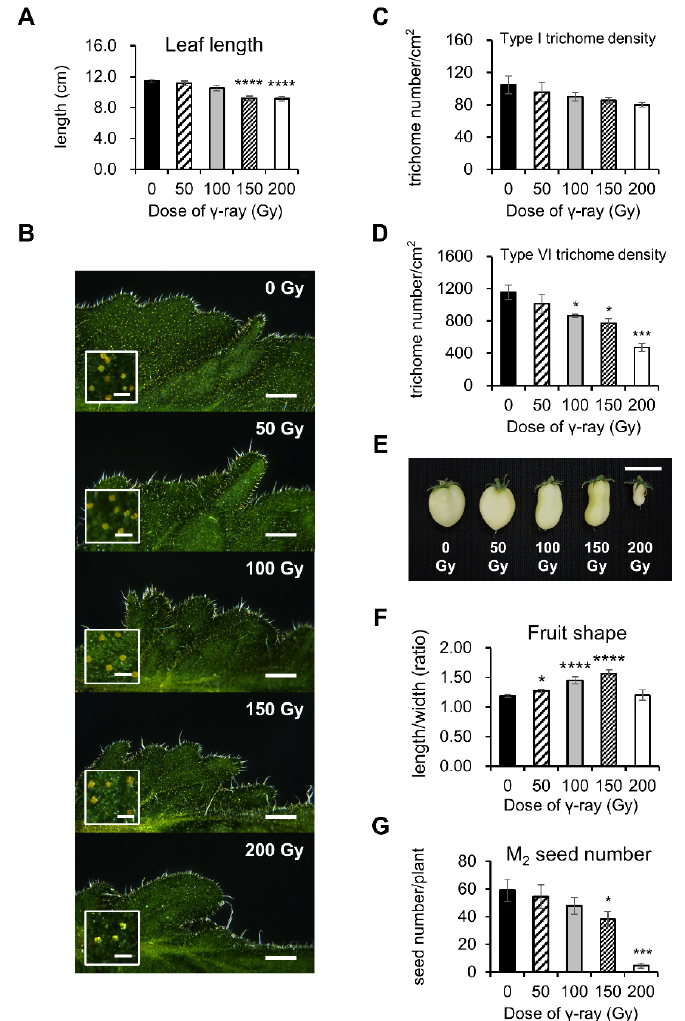
Figure 1. Effect of chronic gamma irradiation on growth and development of tomato M 1 plants. Plants irradiated with 50, 100, 150, or 200 Gy of gamma rays for 4 weeks were compared with control (0 Gy) plants. ( A ) Leaf length of control and gamma-irradiated plants. The length from the center of the plant to the edge of the largest terminal leaflet was measured. Data are presented as mean ± SE of 16 biological replicates for each dose. Asterisks represent significant differences between gamma- irradiated and control plants (unpaired t -test: **** p < 0.0001). ( B ) Dissecting micrographs of the adaxial leaf surfaces of the control and gamma-irradiated plants. Scale bars represent 2 mm. Insets show representative type VI trichomes, and scale bars in the insets indicate 0.2 mm. ( C , D ) Density of type I ( C ) and VI ( D ) trichomes on the adaxial leaves of control and gamma-irradiated plants. Data are presented as mean ± SE of four biological replicates for each dose. Asterisks represent sig- nificant differences between control and gamma-irradiated plants (unpaired t -test: * p < 0.05; *** p < 0.001). ( E ) Shape of mature green fruit in the control and gamma-irradiated plants. Scale bar indi- cates 2 cm. ( F ) Length-to-width ratio of mature-green fruit in control and gamma-irradiated plants. Data are shown as mean ± SE of 12 biological replicates. Asterisks represent significant differences between control and gamma-irradiated plants (unpaired t -test: * p < 0.05; **** p < 0.001). ( G ) M 2 seed number in control and gamma-irradiated M1 plants. Following gamma irradiation, M 1 plants were transferred to a greenhouse and cultivated until 28 weeks from sowing to collect M 2 seeds. Data are presented as mean ± SE of 12 biological replicates for each dose. Asterisks represent significant dif- ferences between gamma-irradiated and control plants (unpaired t -test: * p < 0.05; *** p < 0.001).